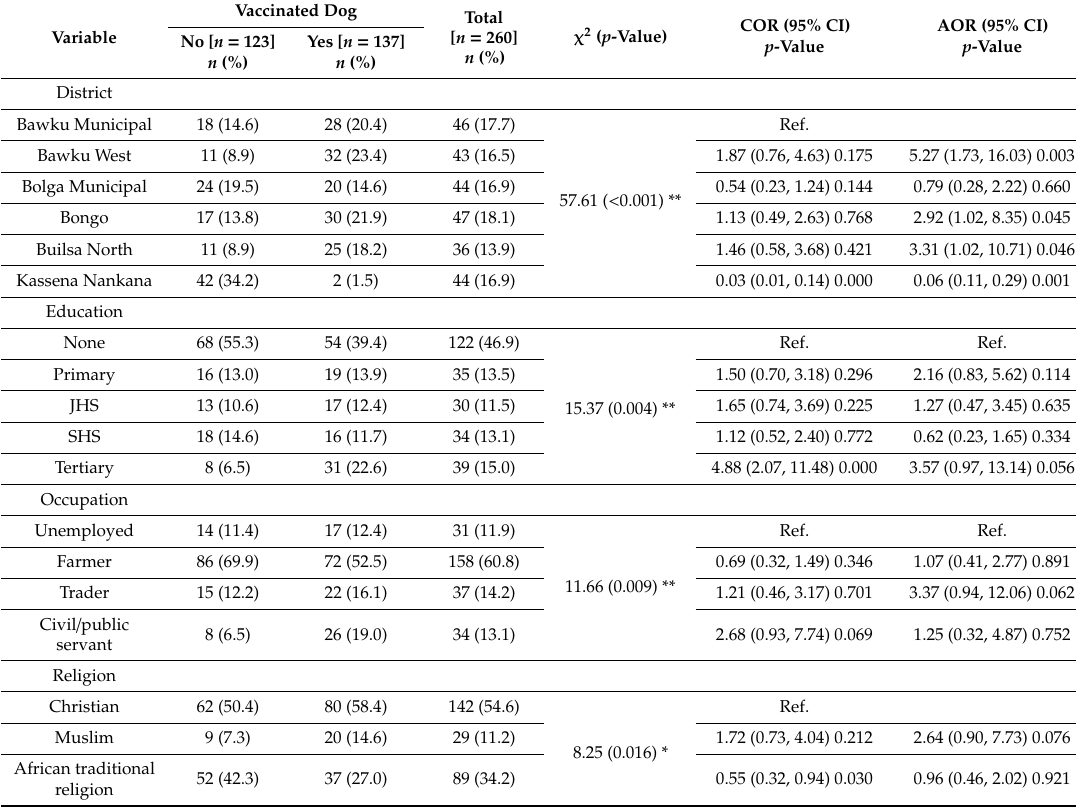
Table 4. Association between socio-demographic characteristics and the vaccination of dogs against rabies and the odds of dog vaccination against